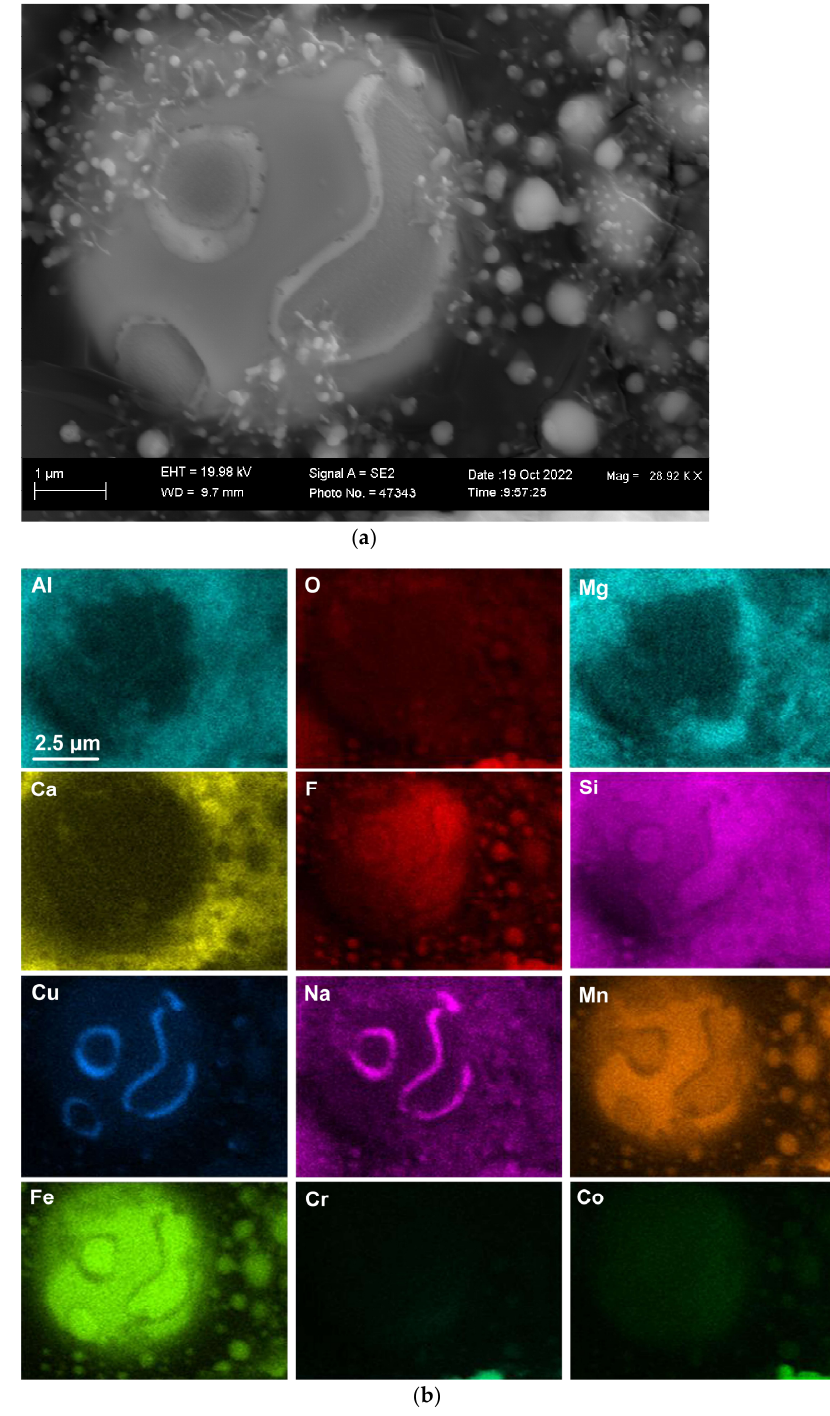
Figure 6. ( a ) BSE image at 28,920 × magnification showing 3D sphere in slag dome in the MP11 post-weld slag, as shown in Figure 5a’s blocked area; ( b ) EDX maps of the FOV (field of view) in Figure